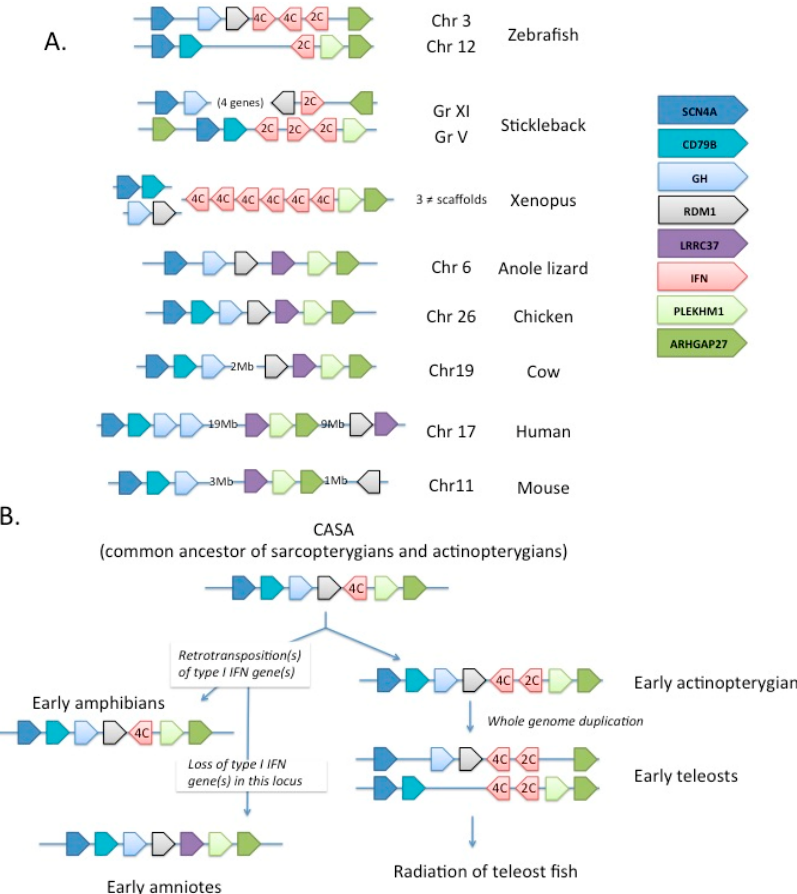
Figure 4. Evolution of the type I IFN locus. ( A ) Current structure of scn4a/ahrgap27 loci in various vertebrate genomes, illustrating the loss of type I IFN gene in this region likely from the common ancestor of amniotes. The color code for the different markers of this synteny group is represented on the right of the panel. IFNs of the four- and two-cysteine types are noted as 4C and 2C; ( B ) Tentative reconstitution of the evolution of this region in Vertebrates, illustrating the presence of type I IFN genes in the scn4a/ahrgap27 locus from the common ancestors of fish and tetrapods, and their loss during the evolution of Amniotes.